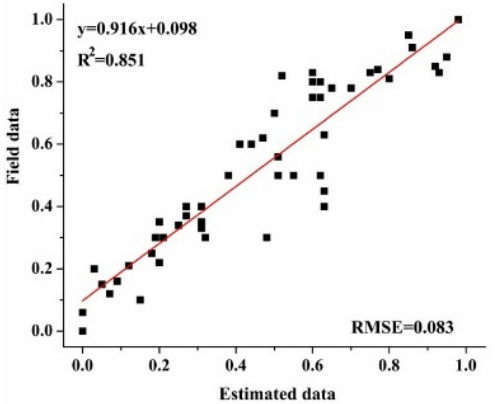
Figure 4. A correlation of field recorded bare ‐ land fraction and the estimated data extracted by LSMA (Linear Spectral Mixture Analysis). The linear fitting for the validation is statistically significant at p < 0.001.